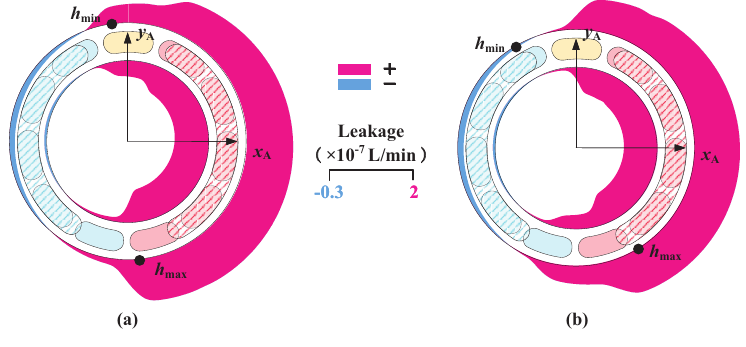
Figure 19. Leakage at 35 MPa. ( a ) θ = 0. ( b ) θ = π